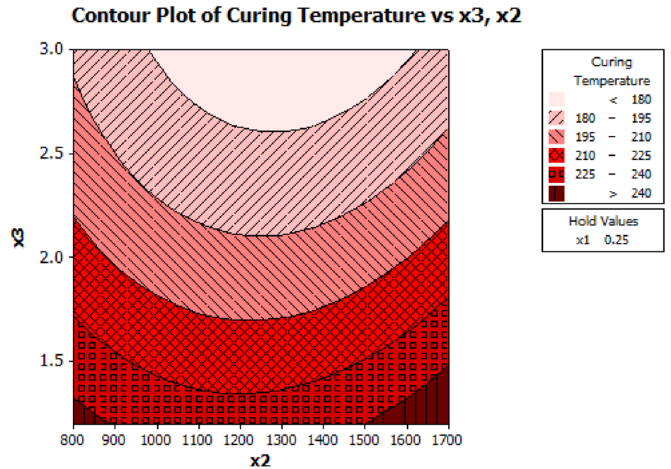
Figure 11. Contour plot for lignin M w (X 2 ) and F/P (X 3 ) on curing temperatures of BPF resoles at 25% substitution of phenol with lignin.